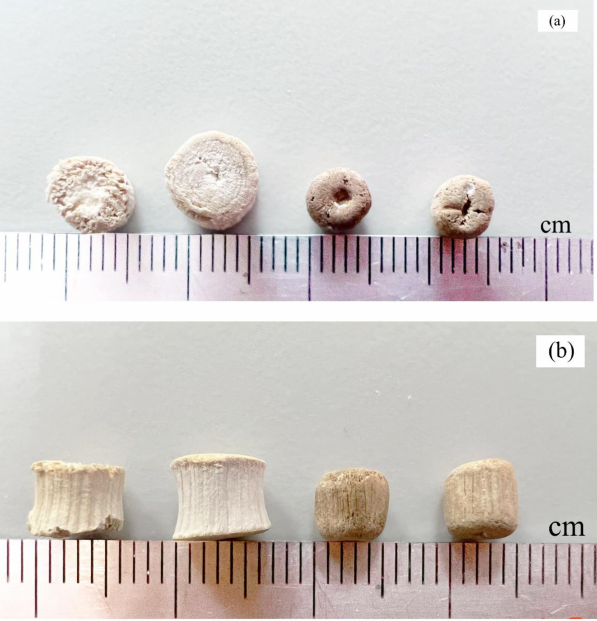
Figure 2. Top-view ( a ) and side-view ( b ) photographs of Lead tree wood-zeolite composites of (from left to right) untreated wood (NR), untreated wood with sonication (NRS), refluxed wood (R) and refluxed wood with sonication